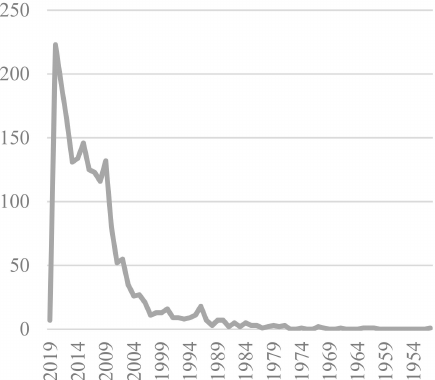
Figure 3. Evolution of scientific research on green jobs.